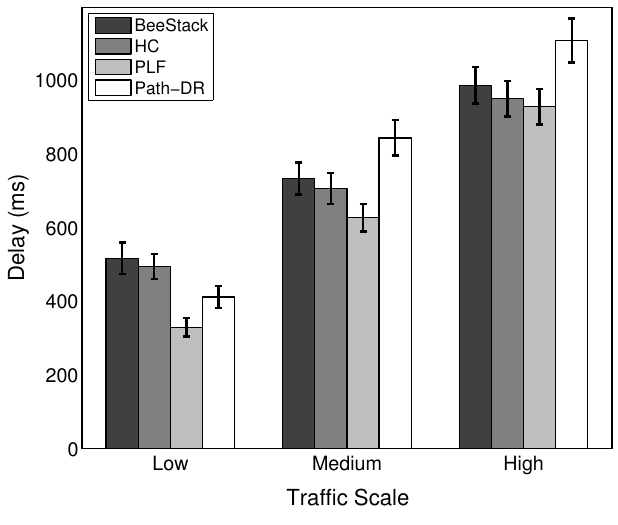
Figure 11. A comparison of the average end-to-end delays with 95% confidence intervals for different routing metrics and traffic conditions.